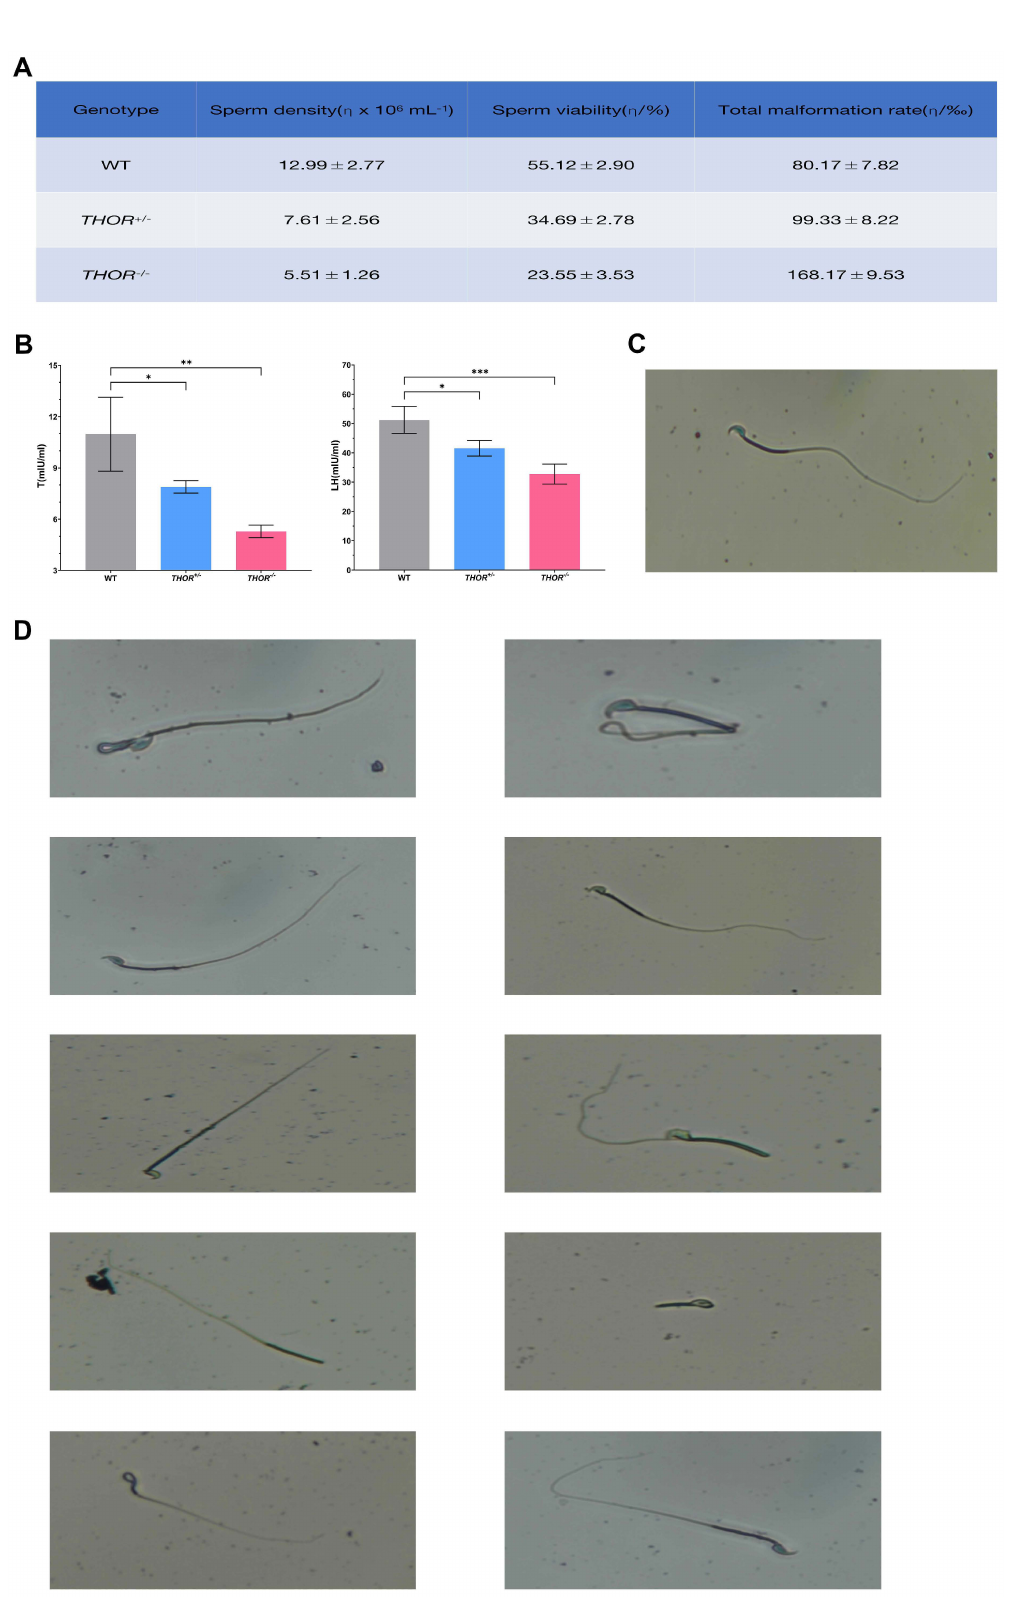
Figure 5. THOR deficiency affects sperm development. ( A ) Comparison of the density, motility, and deformity rates of epididymal sperm in WT and THOR -deficient mice. ( B ) Comparison of the levels of T and LH in the blood of WT and THOR -deficient mice. * indicates p ≤ 0.05 as determined by a t -test, ** indicates p ≤ 0.01 as determined by a t -test, and *** indicates p ≤ 0.001 as determined by a t -test. The data are shown as the mean ± SD from two independent experiments. ( C ) Normal sperm stained with eosin-nigrosin. ( D ) Abnormal sperm from THOR -deficient mice stained with